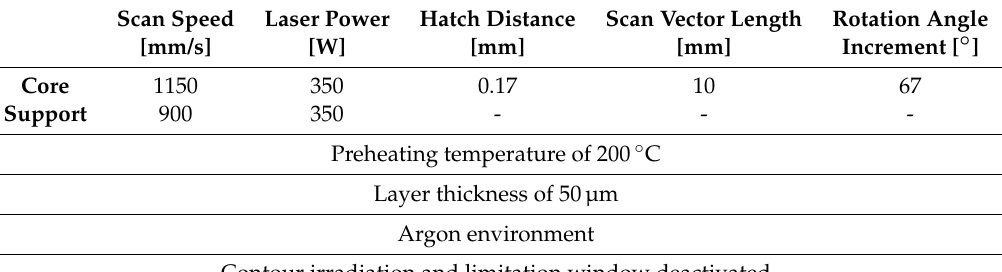
Table 2. Fabrication parameters of laser powder-bed fusion